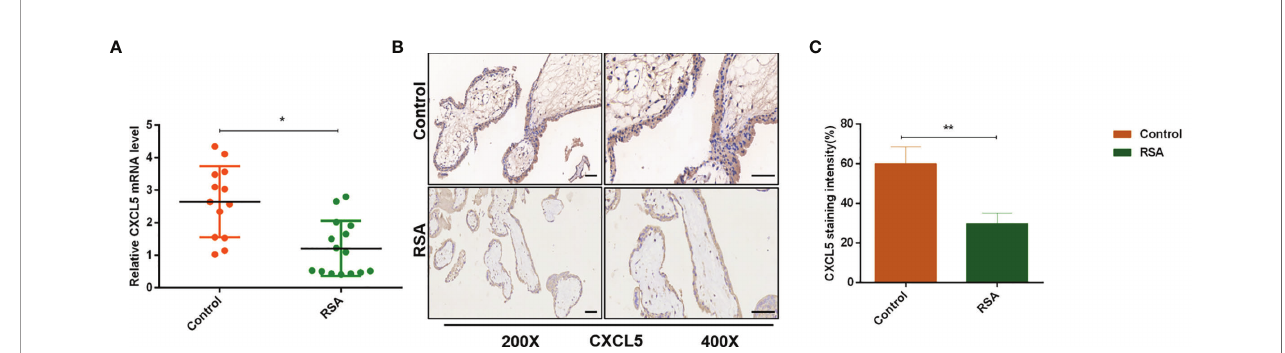
FIGURE 1 | CXCL5 expression in human placental villous tissue from the RSA group and the control group. (A) Expression of CXCL5 mRNA in the RSA group (n = 15) and control group (n = 13) by RT-PCR. (B, C) Representative immunohistochemical staining images and quanti fi cation of CXCL5 in the RSA group (n = 15) and normal group (n = 13). Relative gene expression was normalized to GAPDH. ImageJ is used to quantify the staining intensity. Magni fi cation, ×200 and ×400. Scale bars = 100 m m. Data are presented as the mean ± SD. Results are reported as fold change compared with the control group. (* p < 0.05, ** p < 0.01). RSA, recurrent spontaneous abortion; mRNA, messenger RNA; RT ‐ PCR, quantitative real-time polymerase chain reaction; CXCL5, C-X-C motif chemokine ligand 5; IHC,